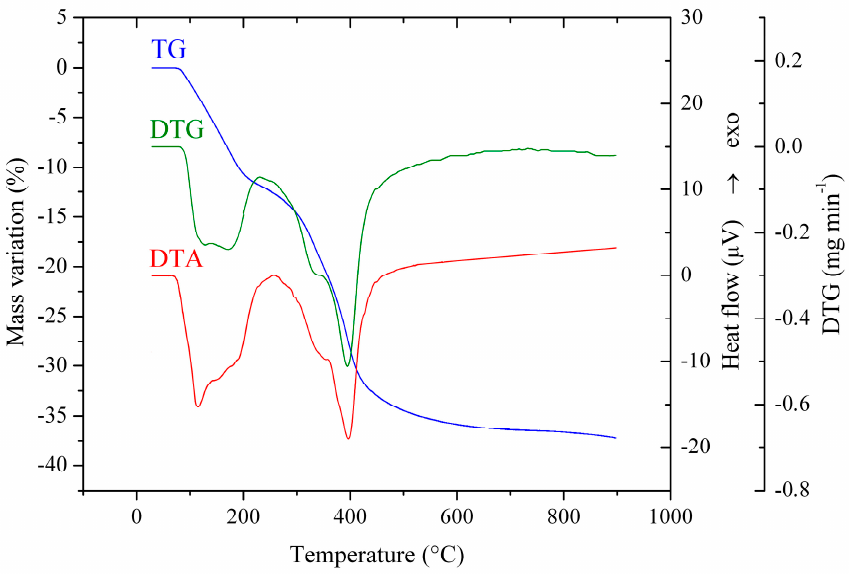
Figure 3. TG-DTG-DTA curves of the Co(3)CuCeMgAl LDH precursor. Table 3. Cationic composition of the calcined oxide catalysts estimated by EDX spectroscopy.